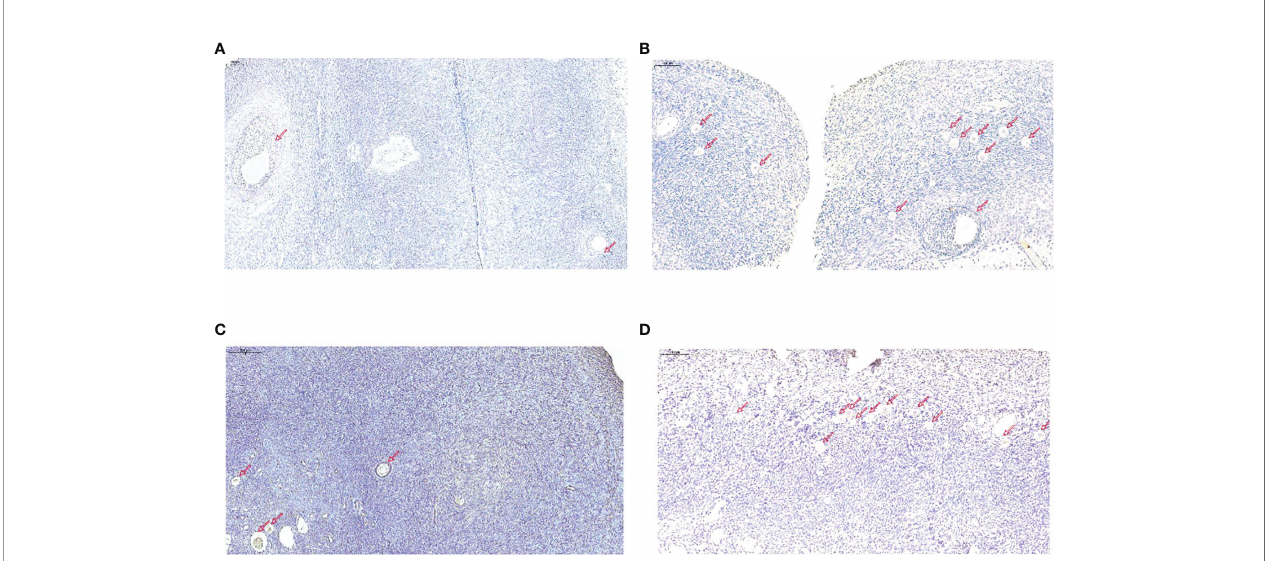
FIGURE 6 | TUNEL analysis of ovarian tissues in the normal group and PCOS group. (A, C) TUNEL staining of ovarian tissues in control group. Scale bar = 200 µm. (B, D) TUNEL staining of ovarian tissues in PCOS group. Scale bar = 200 µm. Scale bar = 200 µm. Red arrows indicate primary, secondary or antral follicles.